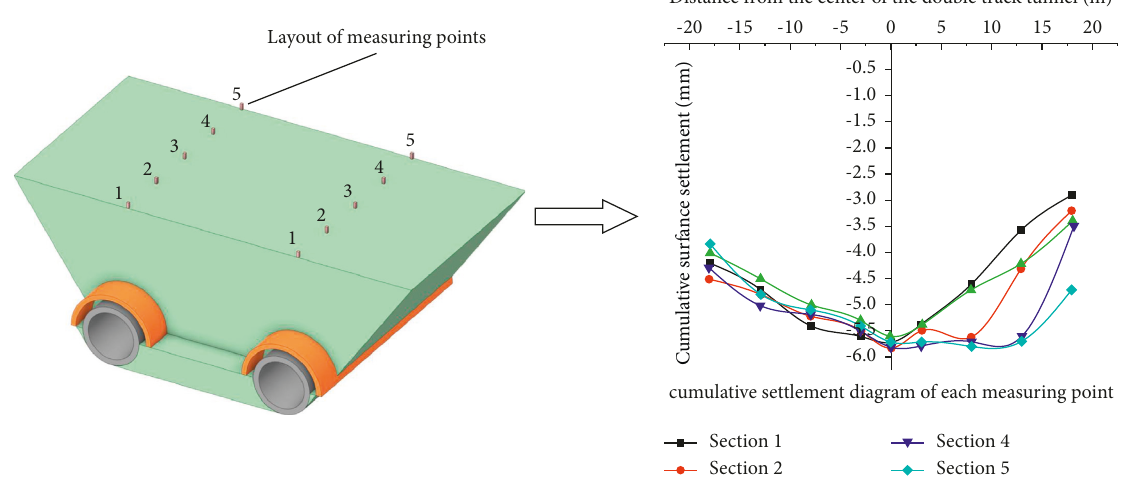
Figure 7: Layout of tunnel measuring points and cumulative settlement of each measuring Figure 7 for the specific layout location. A transverse monitoring section was arranged every 10 m in the railway area, and a total of 5 transverse measurement sections were arranged in the railway area. The specific location is shown in Figure 7. A total of 45 surface settlement observation points were arranged in the railway area.